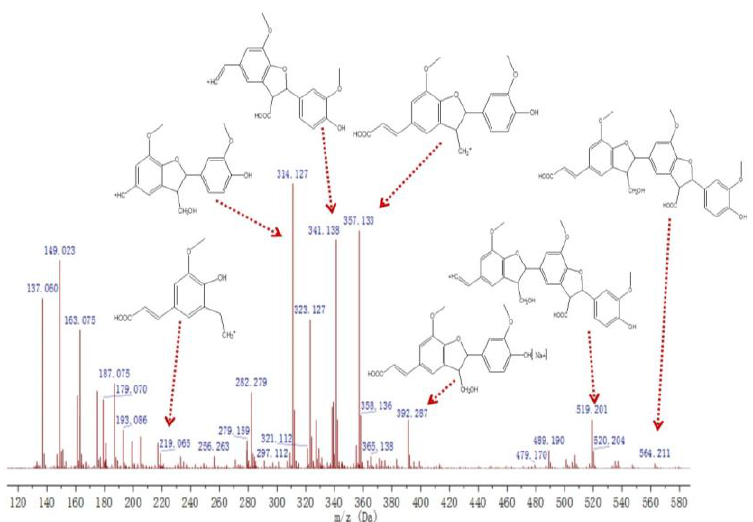
Figure 12. Mass spectrum of the compound G 2 .